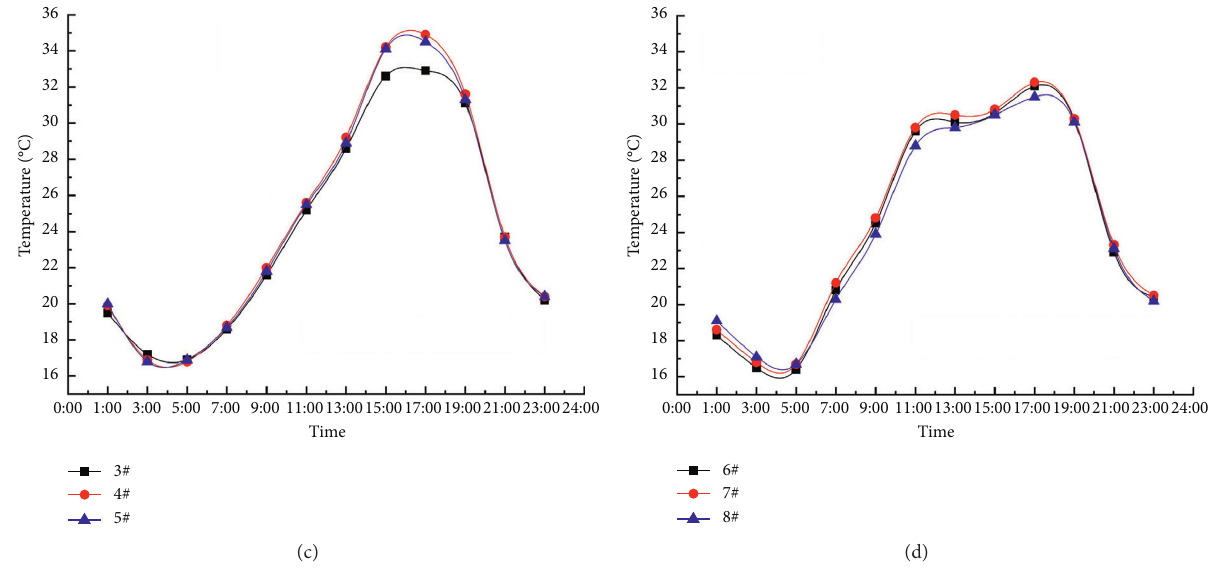
Figure 6: Curves of ambient temperature with time on June 6, 2021, at different measuring points. (a) Ambient temperature, measuring point #1 and measuring point #2. (b) Ambient temperature, measuring point #9 and measuring point #10. (c) Measuring points #3, # 4, and #5. (d) Measuring points #6, #6, and #8.